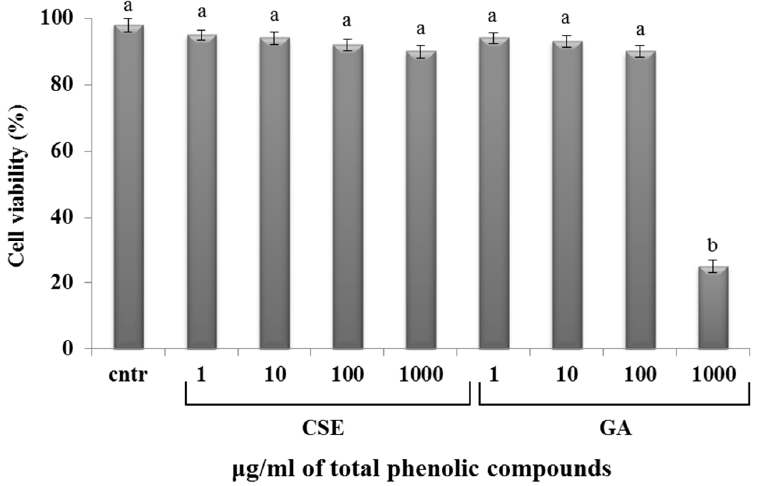
Figure 2. Percentage of cell viability. The data represent the mean ± SD of triplicate cultures ( n = 3). Different letters on the columns indicate statistically significant differences (cntr = control). The concentration reported on the x axis refers to the total phenolic compounds contained in the chestnut shell extract (CSE). The graph is representative of both blood and intestinal cell cultures.